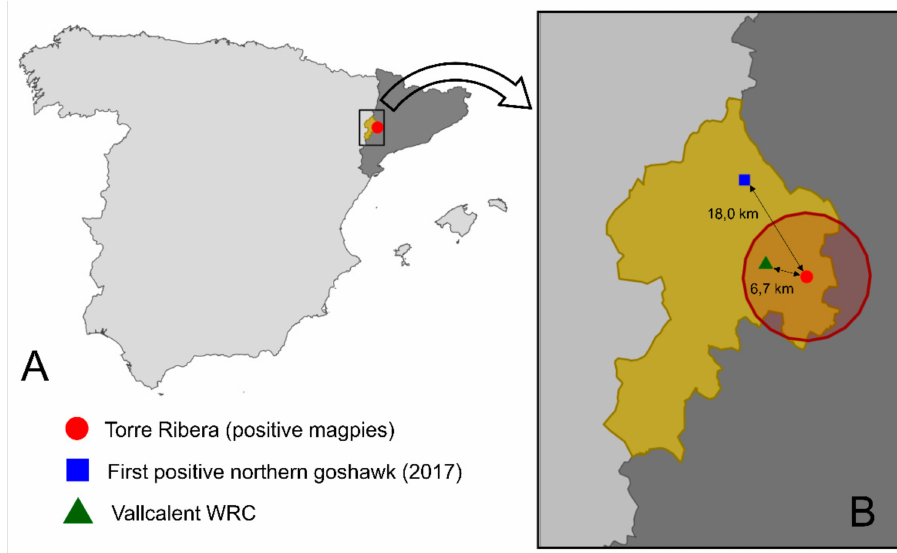
Figure 1. ( A ) Location of Torre Ribera, the magpies sampling area (red point) within Segri à region (in gold), Catalonia (dark grey) and Spain (light grey). ( B ) Zoomed area with Torre Ribera sampling area (red point), 10 km bu ff er area (dark red circle), location of the first positive northern goshawk (blue square) and Vallcalent Wildlife Recovery Center (WRC) (green